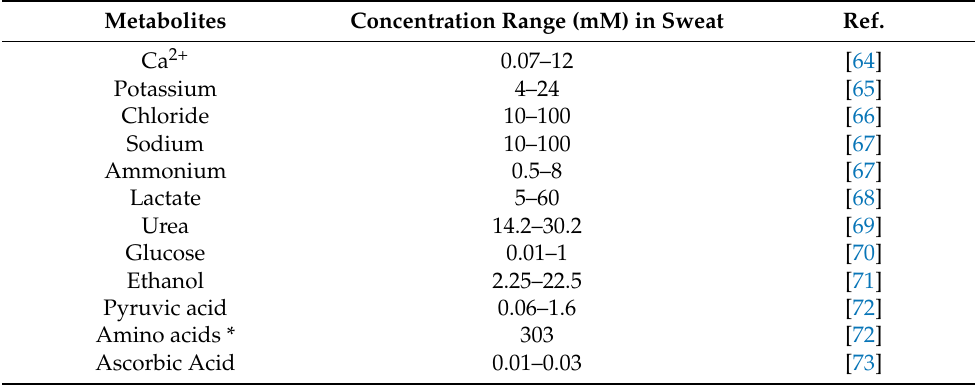
Table 1. The typical ions concentration in human